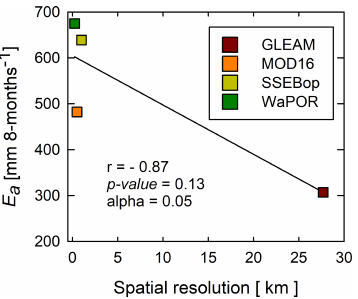
Figure 14. Point scale-based correlation of spatial resolution with actual evaporation of satellite-based